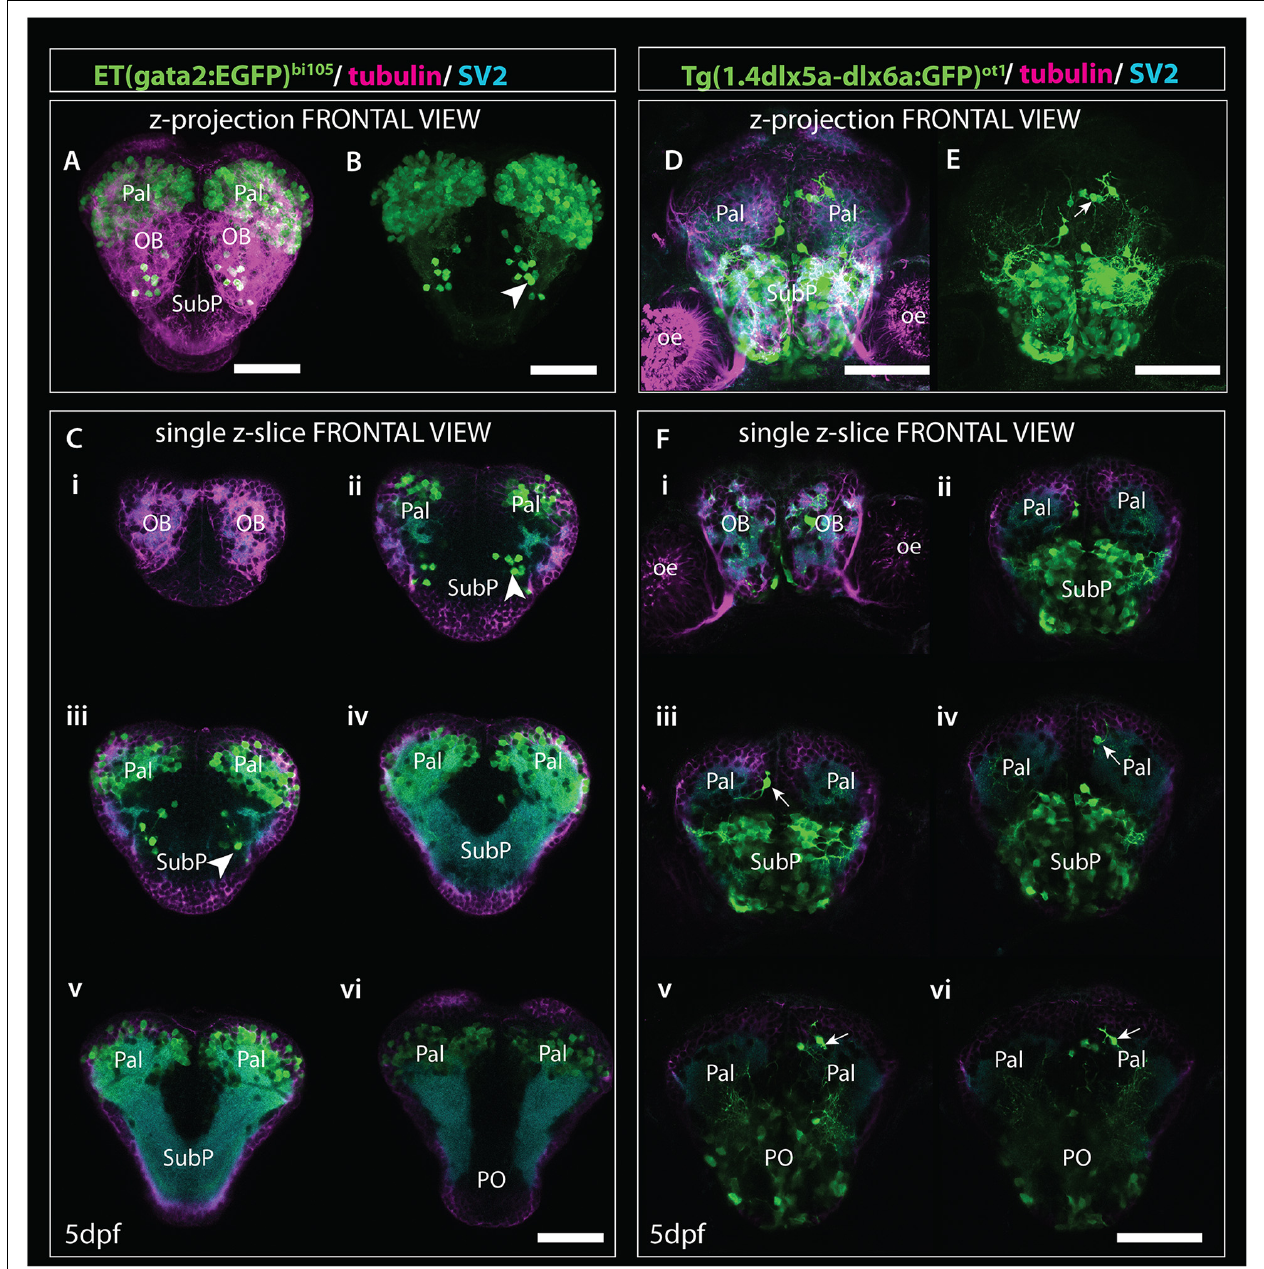
FIGURE 11 | Comparison of gata2:EGFP and 1.4dlx5a-dlx6a:GFP expression in frontal view (z-projections and single z-slices). (A) Frontal view of the telencephalon of a 4dpf Et (gata2:EGFP) bi105 fish labeled with anti-EGFP (green), anti-tubulin (magenta) and anti-SV2 antibodies (cyan). (B) EGFP channel only. (Ci–vi) Single z-slices from rostral (i) to caudal levels (vi) . Arrowheads in panel (B,Cii,iii) point to gata2:EGFP + subpallial neurons. (D,E) Frontal view of the telencephalon of a 4dpf Tg( 1.4dlx5a-dlx6a :GFP) ot 1 fish labeled with anti-EGFP (green), anti-tubulin (magenta) and anti-SV2 antibodies (cyan). (E) GFP channel only. (Fi–vi) Single z-slices from rostral (i) to caudal levels (vi) . [Arrows in panels (E,Fiii,vi) ] label 1.4dlx5a-dlx6a:GFP+ interneurons in the pallium. Panels (Ci–vi,Fi–vi) are equivalent rostrocaudal levels. Scale bars: 50 µ